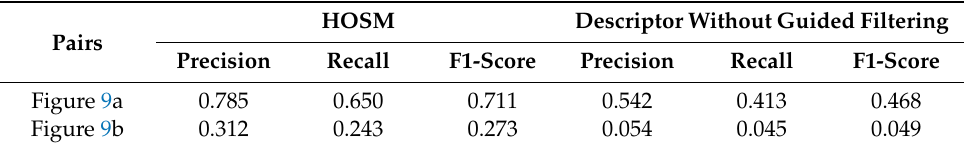
Table 1. Precision, recall and F1-score for HOSM and descriptor without guided filtering.